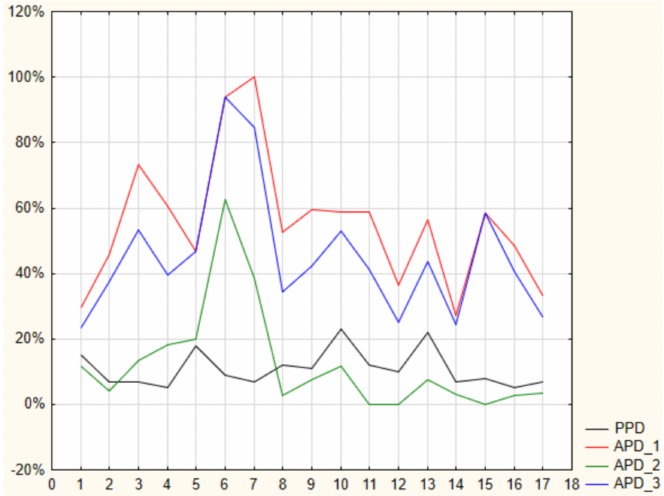
Figure 5. Comparison between the values of APDs and